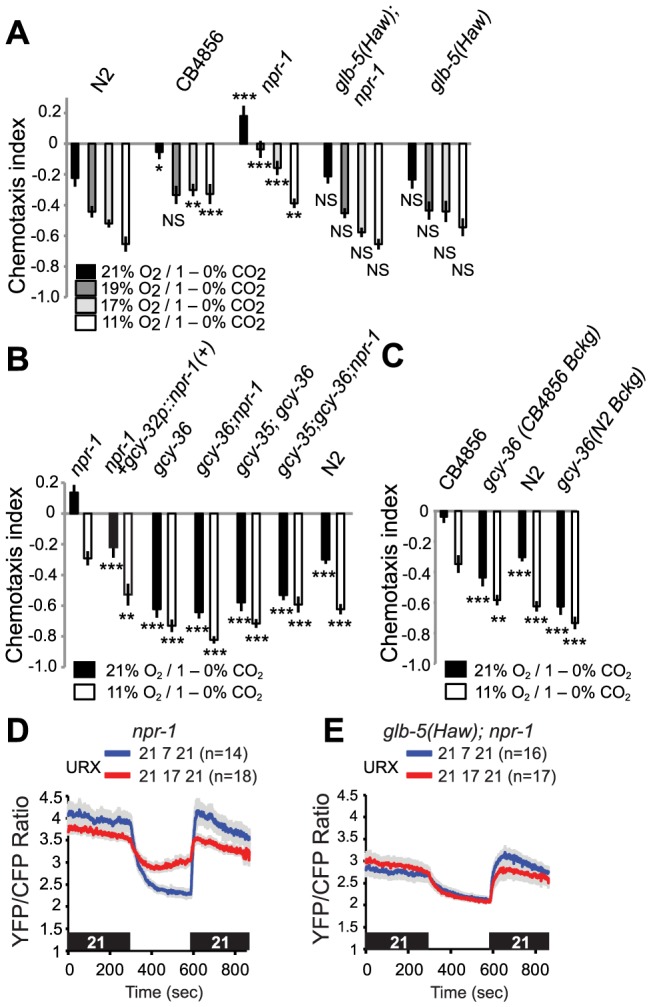
Re-configuring O2 sensing circuits by altering the npr-1 and glb-5 genes alters CO2 avoidance behavior.A. Tuning of CO2 avoidance behavior by different O2 concentrations in N2 (Bristol), CB4856 (Hawaiian), npr-1(ad609), glb-5(Haw); npr-1(ad609), and glb-5(Haw) animals. All assays used a 1–0% CO2 gradient. Statistical comparisons are to the N2 response at the corresponding O2 concentration, *** p<0.001; ** p<0.01; *p<0.05 (Anova, p value protected Fisher's LSD). B. gcy-35 and gcy-36 mutants strongly avoid CO2 regardless of genotype at the npr-1 locus. Statistical comparisons are to the npr-1 response at the corresponding O2 concentration. ***, p<0.001, **, p<0.01, Anova, Bonferroni corrected p value). C. CB4856 (Hawaii) animals defective in gcy-36 strongly avoid CO2 regardless of O2 levels. Statistical comparisons are to the CB4856 response at the corresponding O2 concentration. ***, p<0.001, **, p<0.01, Anova, Bonferroni corrected p value). D, E. Tonic Ca2+ levels in URX neurons of glb-5(Haw); npr-1 animals kept at 21% O2 and 17% O2 is lower than Ca2+ levels in URX in npr-1 animals kept at the corresponding O2 concentrations. Ca2+ measurements were made using cameleon YC2.60.